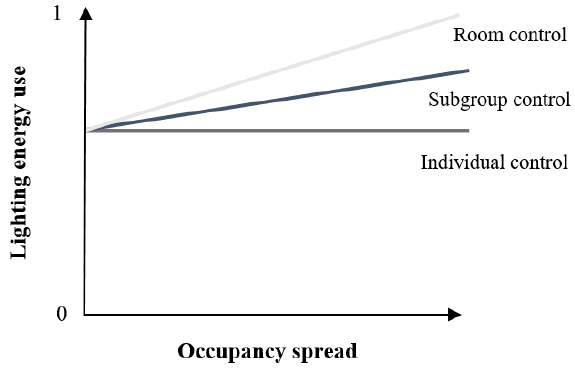
Figure 3. The expected relationship between the relative occupancy spread and lighting energy waste for the different control strategies for an open-plan office space.